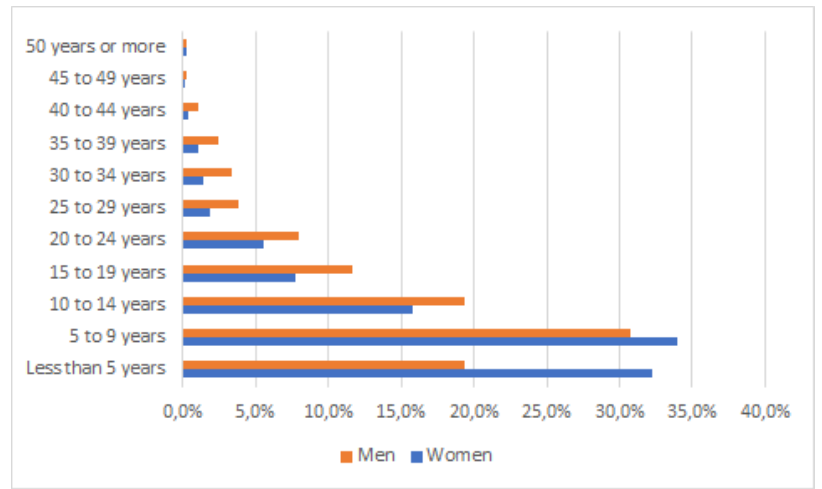
Figure 6. Experience and gender (adapted from [49]).